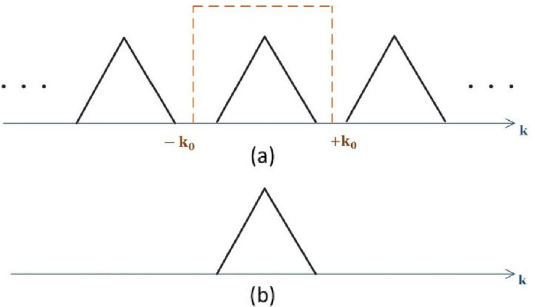
Figure 4. Filtering mechanism of the pattern function around the visible region. ( a ) Periodic function of F ( u, v ) and the filter position. ( b ) Regenerated function after